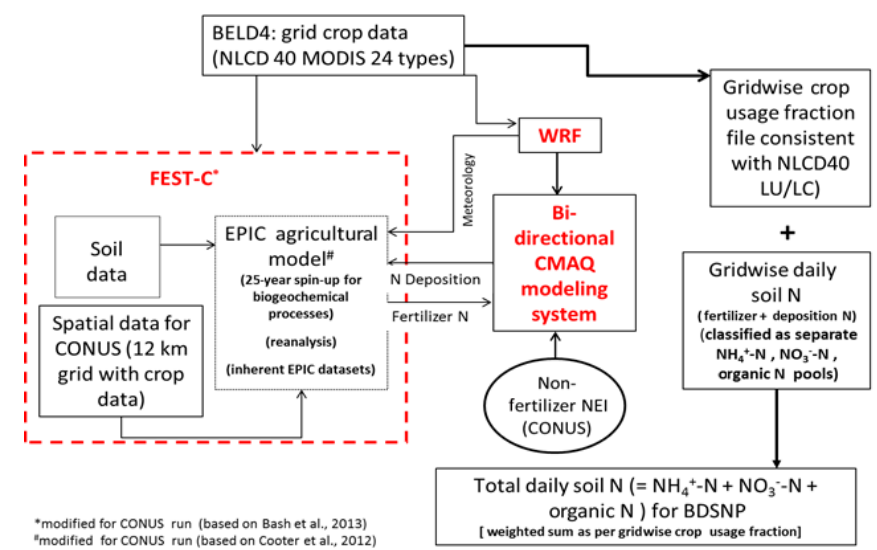
Figure 3. Modeling framework for obtaining total soil N from EPIC using